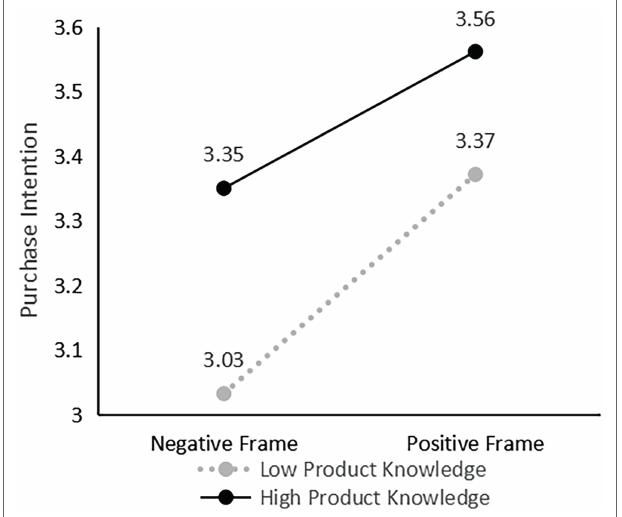
FIGURE 1 | Moderating effect of knowledge level on framing